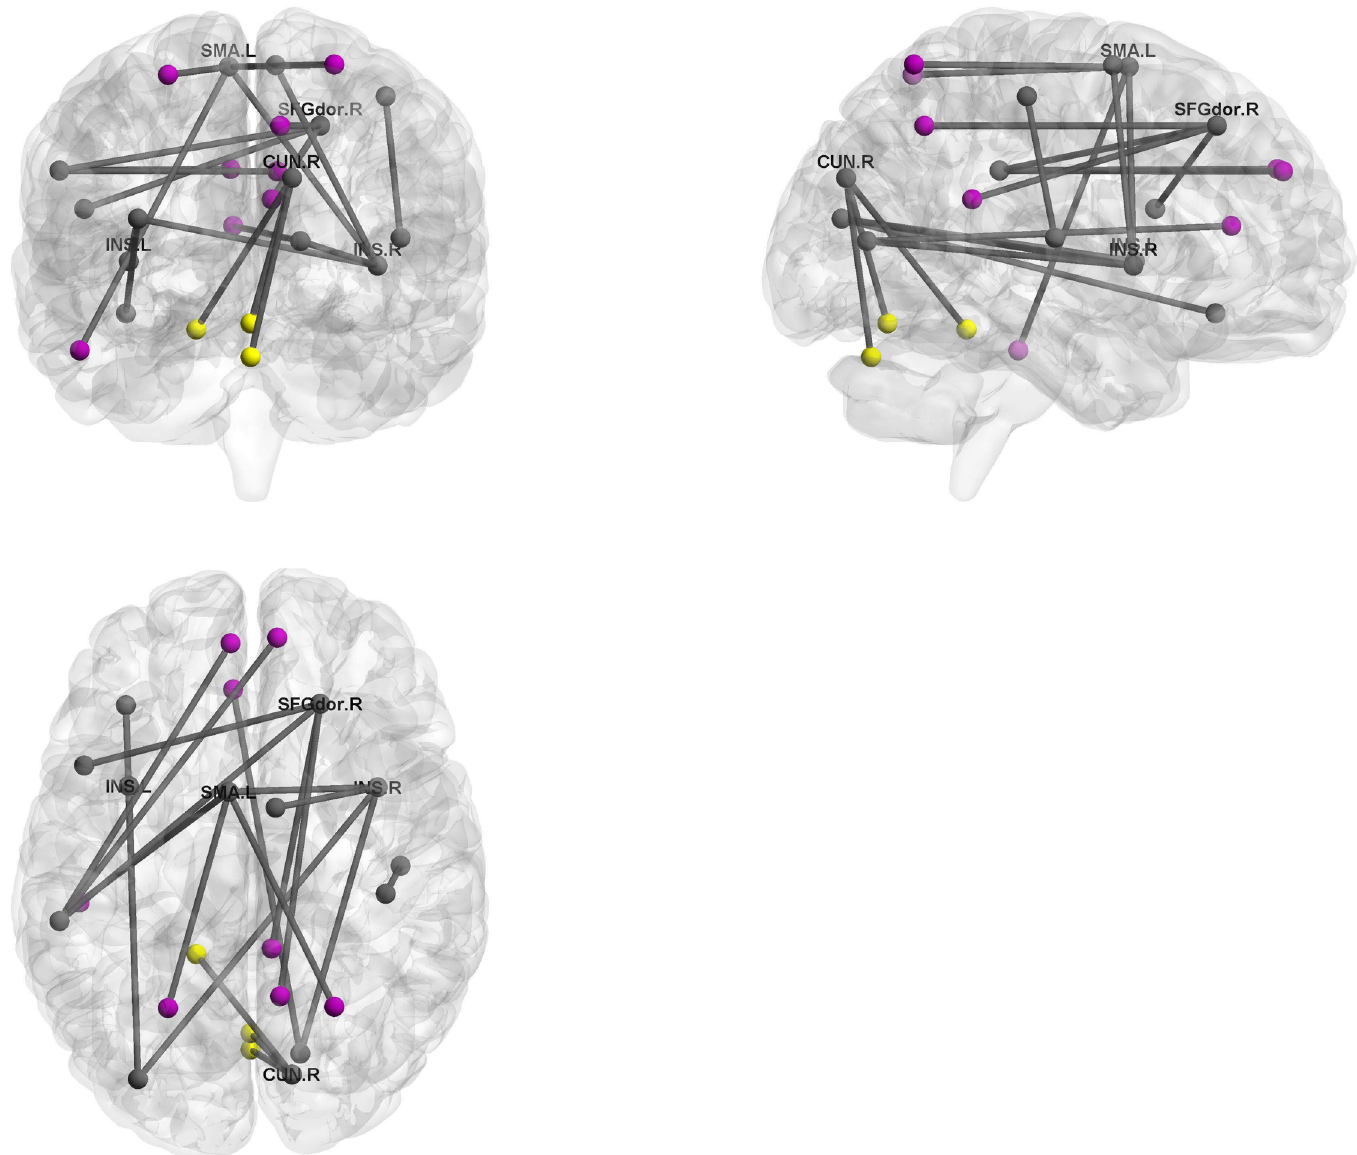
Fig 10. Contributing functional connectivity in first latent component. Purple and yellow nodesrepresent brain areas within the default mode network and cerebellum , respectively.SFGdor.R: right superior frontal gyrus , INS: insula , SMA.L: left supplementary motor area , CUN.R: right cuneus .